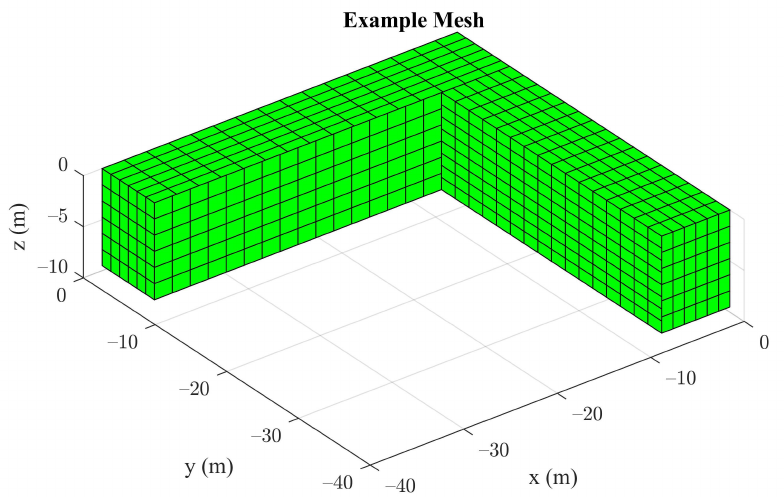
Figure 10. A graph showing a surface mesh of the platform below the waterline. Due to the symmetry in the two planes, only one quarter of the platform was generated.